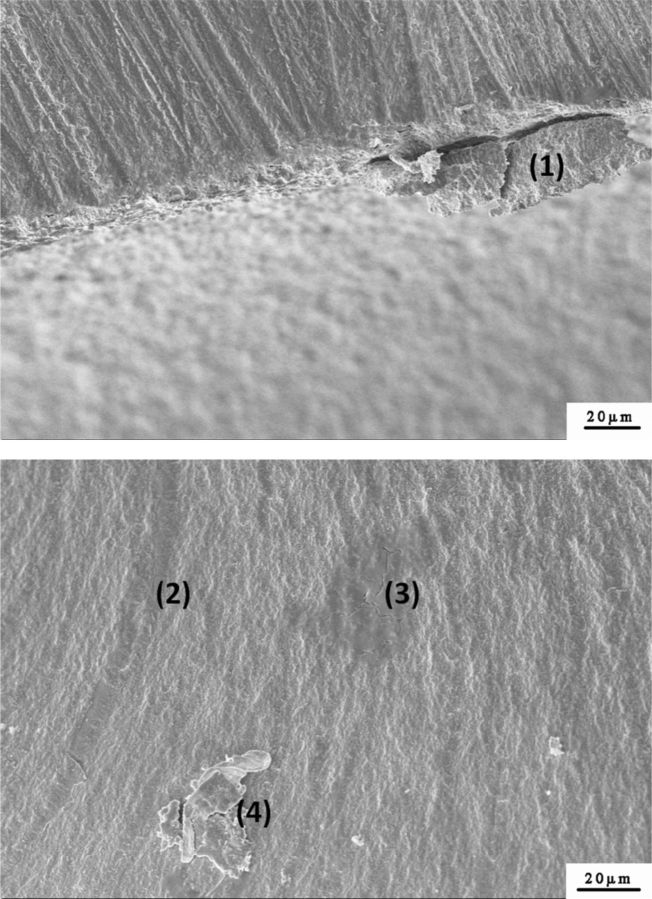
Scanning electron micrographs of the fractured surfaces of the CAD/CAM Y-TZP dental ceramics: (1) surface flaw, (2) hackle line, (3) interior pore and (4) interior flaw.